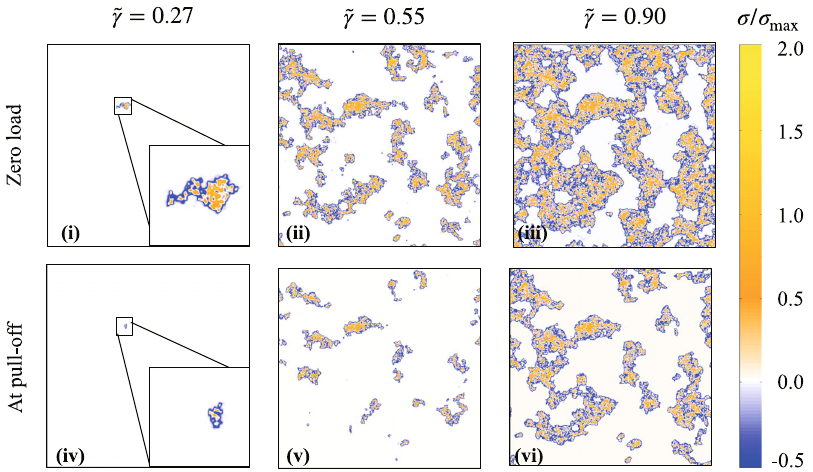
Fig. 3 Stress fields of configuration at zero-load (top row) and right before snap-off (bottom row) for reduced surface energies γ  at the large - γ  end of the non-sticky regime (left column, 0.27  γ  ), in the center of the cross-over regime (center column, 0.55  γ  ), and at the low - γ  end of the sticky regime (right column, 0.90  γ  ). The labels (i)–(vi) correspond to those used in Fig.